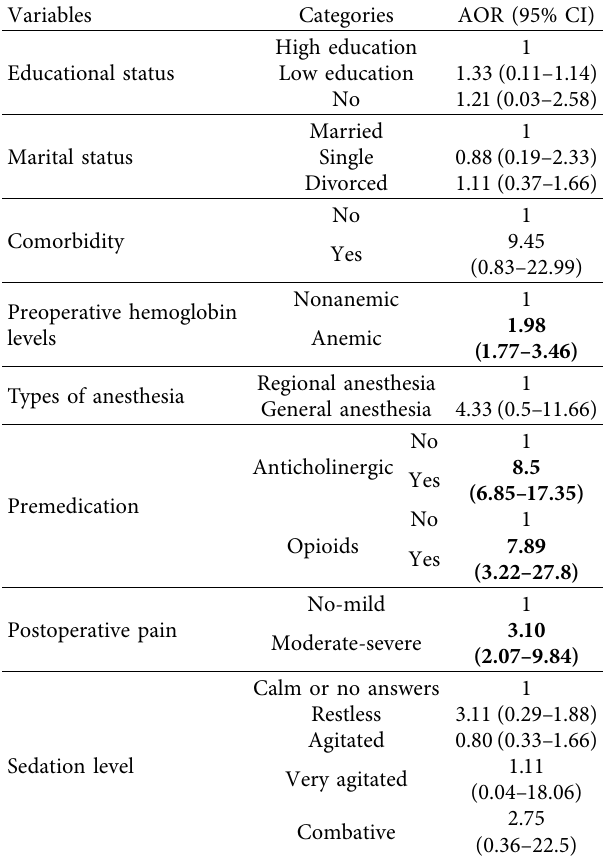
Table 4: Results of multivariable logistic regression of factors independently associated with the emergence delirium in older patients who underwent elective surgery at Teaching Hospitals of Ethiopia, Ethiopia ( n �